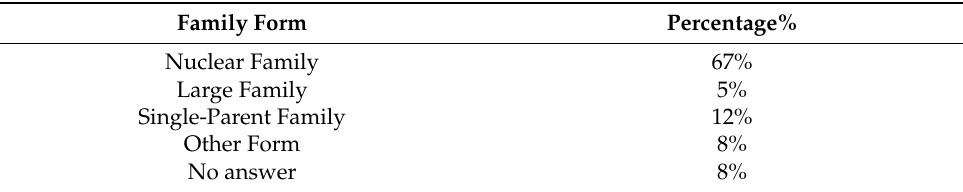
Table 4. Family Form.